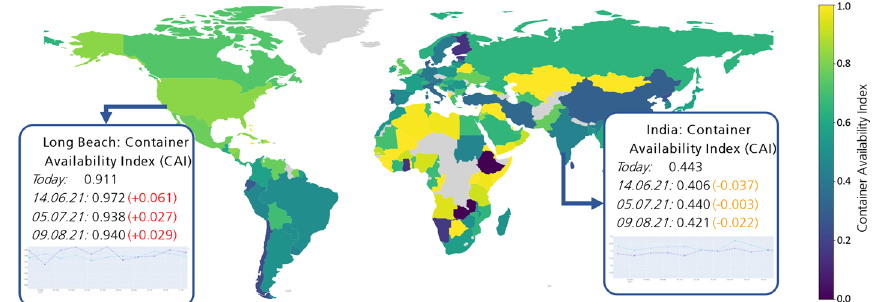
Fig. 13 Forecasts of the container availability index on 7th June 2021 made on 9th May 2021 for forty-foot containers. Source : Own